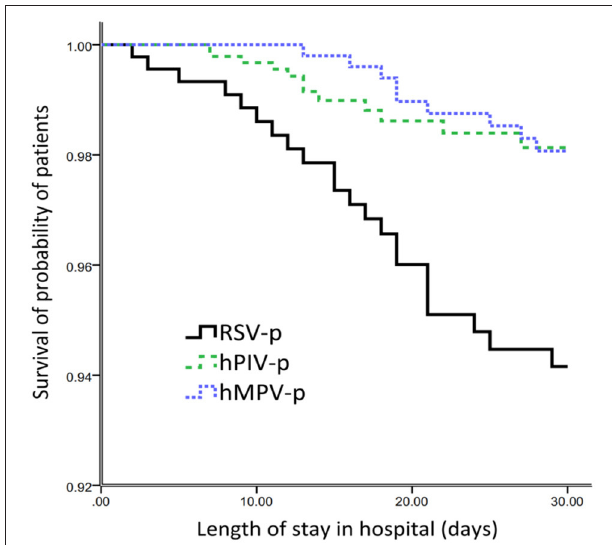
FIGURE 4 | Survival rate of patients hospitalized with the three types of PMVs-p (censored at 30d after admission).